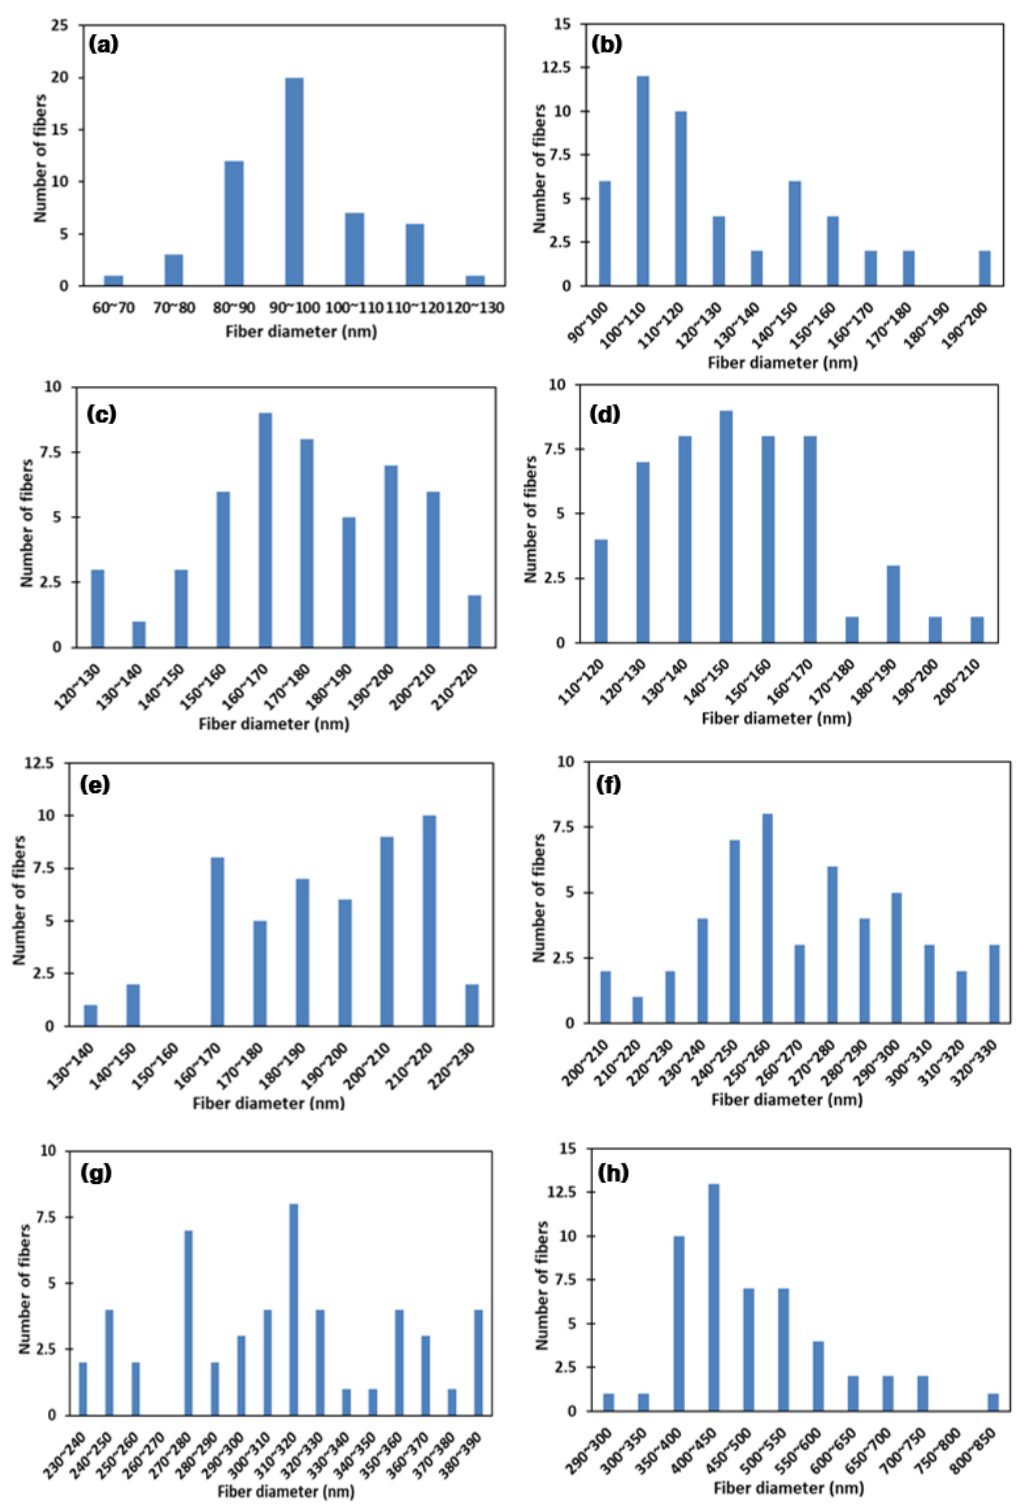
Figure 3. The fiber diameter distributions with various PVA solution concentrations: ( a ) 8 wt%, ( b ) 9 wt%, ( c ) 10 wt%, ( d ) 11 wt%, ( e ) 12 wt%, ( f ) 13 wt%, ( g ) 14 wt%, and ( h ) 15 wt%.